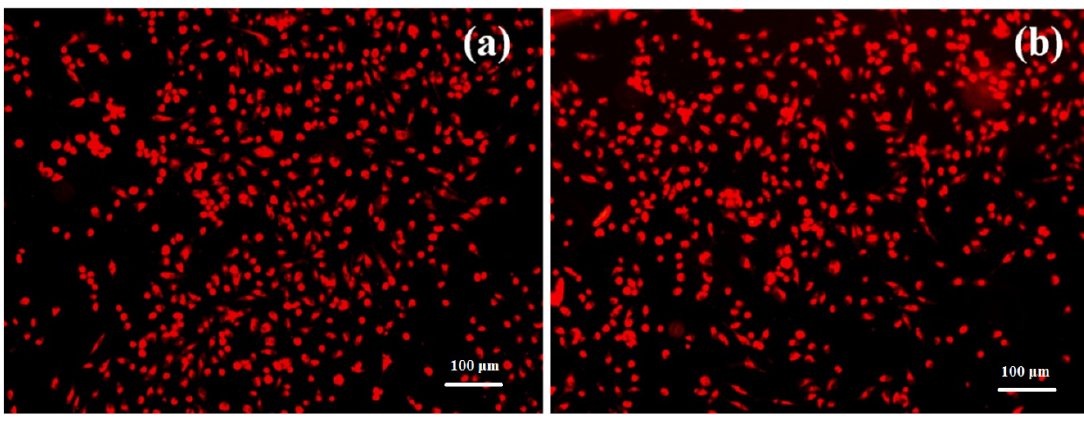
Figure 9. Fluorescence microscopy images of endothelial cells grown in the presence